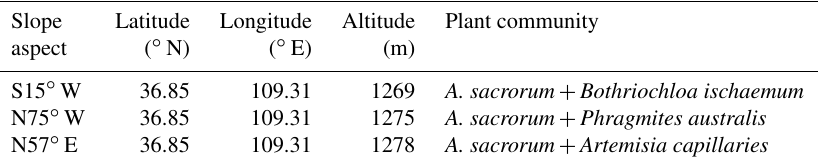
Table 1. Characteristics of the sampling